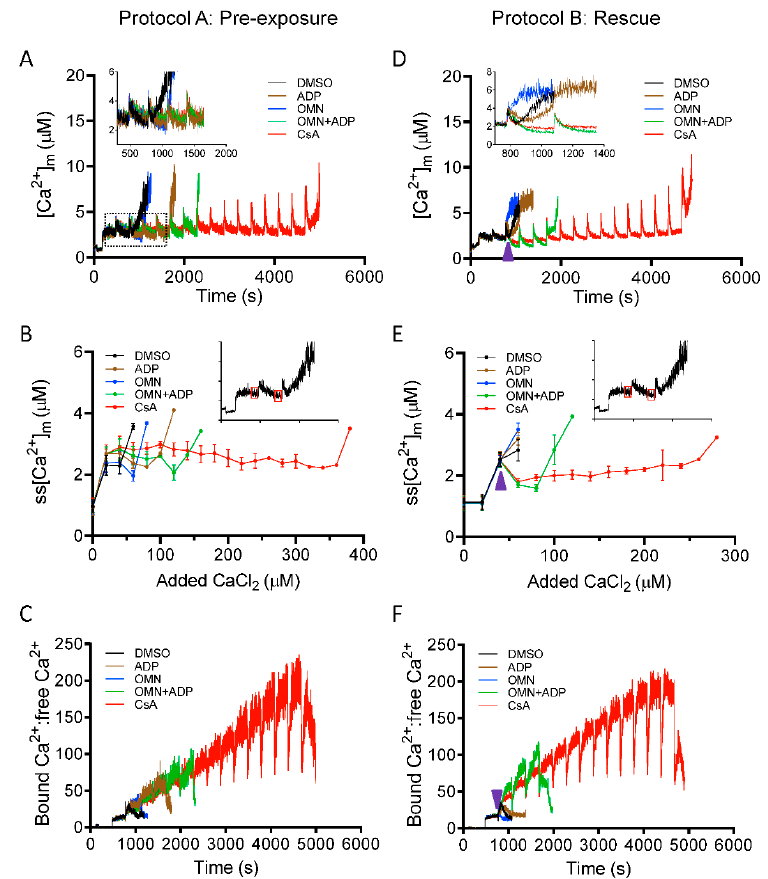
Figure 3. Effect of CsA and AdN on intra-matrix free Ca 2+ ([Ca 2+ ] m ) dynamics. Mitochondrial Ca 2+ uptake and buffering for each treatment groups, DMSO (control; black trace), CsA (red trace), ADP (brown trace), oligomycin (OMN, blue trace), or combination of OMN+ADP (green trace) are shown using the protocols depicted in Figure 1. Mitochondrial suspension was exposed to 0.5 µM CsA, 250 µM ADP, 10 µM OMN, or OMN+ADP before adding boluses of 20 µM CaCl 2 (Protocol A; left column). Mitochondrial suspension was exposed to added boluses of CaCl 2 (20 µM) and rescued from mPTP opening (Protocol B; right column) with similar interventions as in Protocol A, at a time point at which it would initiate mPTP opening. Representative traces show changes in [Ca 2+ ] m over time in delay of mPTP opening ( A ) and rescue of mitochondria from mPTP opening ( B ). Insets (A,B) show Ca 2+ uptake kinetics in detail. Steady-state [Ca 2+ ] m (ss[Ca 2+ ] m ), 270 s after initiation of Ca 2+ uptake, plotted as function of added Ca 2+ (20 µM) every 300 s in delay of mPTP opening ( C ) and rescue of mitochondria from mPTP from opening ( D ). Insets (C,D) indicate the time points at which ss[Ca 2+ ] m was calculated. Change in matrix-bound Ca 2+ :free Ca 2+ over time in delay of mPTP opening ( E ) and rescue of mitochondria from mPTP opening ( F ). Arrowhead indicates time of addition of DMSO, ADP, OMN, OMN+ADP, or CsA during Protocol B.